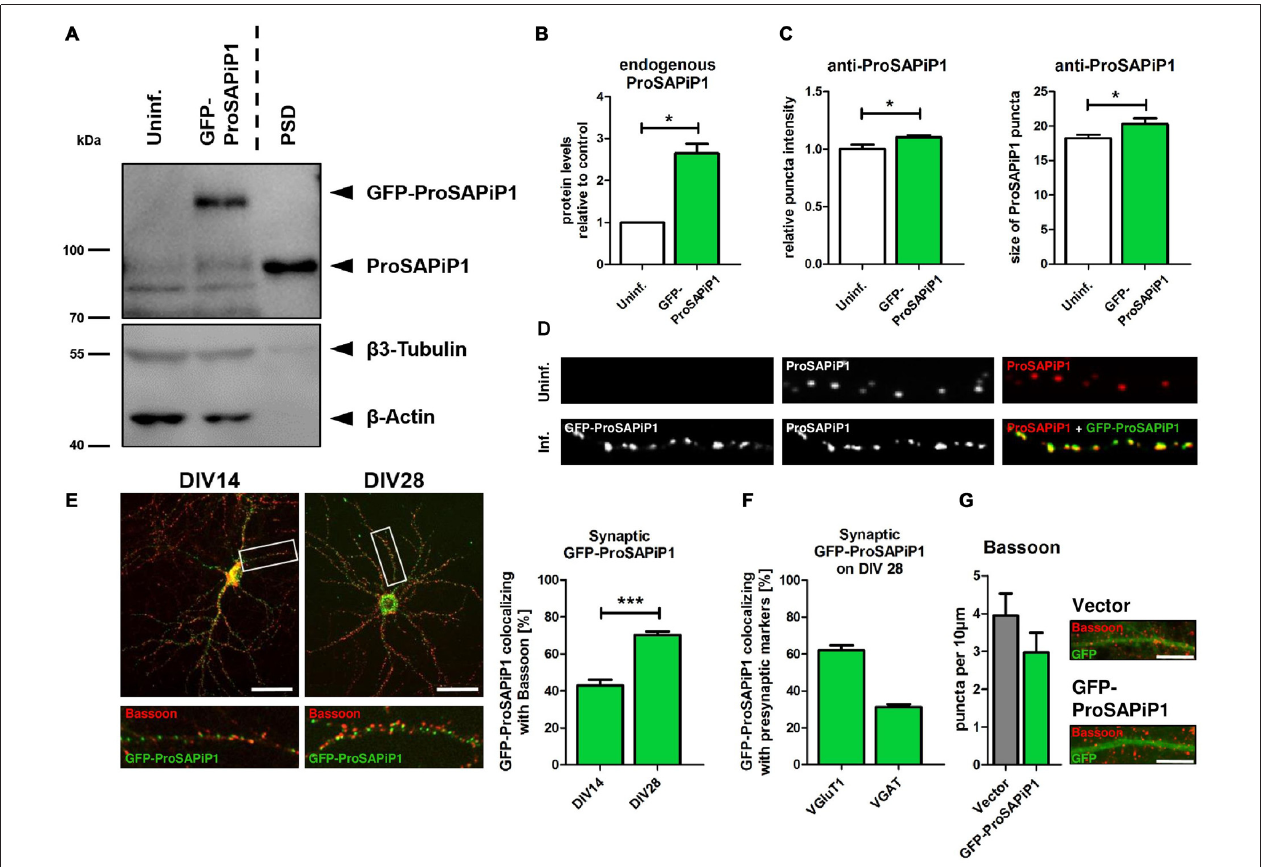
FIGURE 1 | Synaptic distribution of green fluorescent protein-ProSAP-interacting protein 1 (GFP-ProSAPiP1) in primary hippocampal neurons. (A) GFP-ProSAPiP1 is clearly visible at the expected molecular weight ( ∼ 125 kDa) in infected primary hippocampal culture at DIV28, whereas no signal is observed in the uninfected control (Uninf.). Post-synaptic density (PSD) fraction from rat hippocampus was loaded as reference for endogenous ProSAPiP1, which is present in all lanes ( ∼ 85 kDa). β 3-Tubulin and β -Actin serve as loading control. (A,B) Protein levels of endogenous ProSAPiP1 were significantly increased after overexpression of GFP-ProSAPiP1 at DIV28. (B) Statistical analysis was performed using unpaired two-sided t -test. ∗ p < 0.05; n = 3 lysates from three independent cultures for each condition. (C,D) Both ProSAPiP1 puncta intensity and ProSAPiP1 cluster size were significantly increased after overexpression of GFP-ProSAPiP1 in primary hippocampal culture at DIV28. Statistical analysis was performed using unpaired two-sided t -test. ∗ p < 0.05; n = 10 neurons from two independent cultures. (E) Exemplary hippocampal neurons, infected with GFP-ProSAPiP1 (green) and immunostained for Bassoon (red) on DIV14 and DIV28 as indicated.